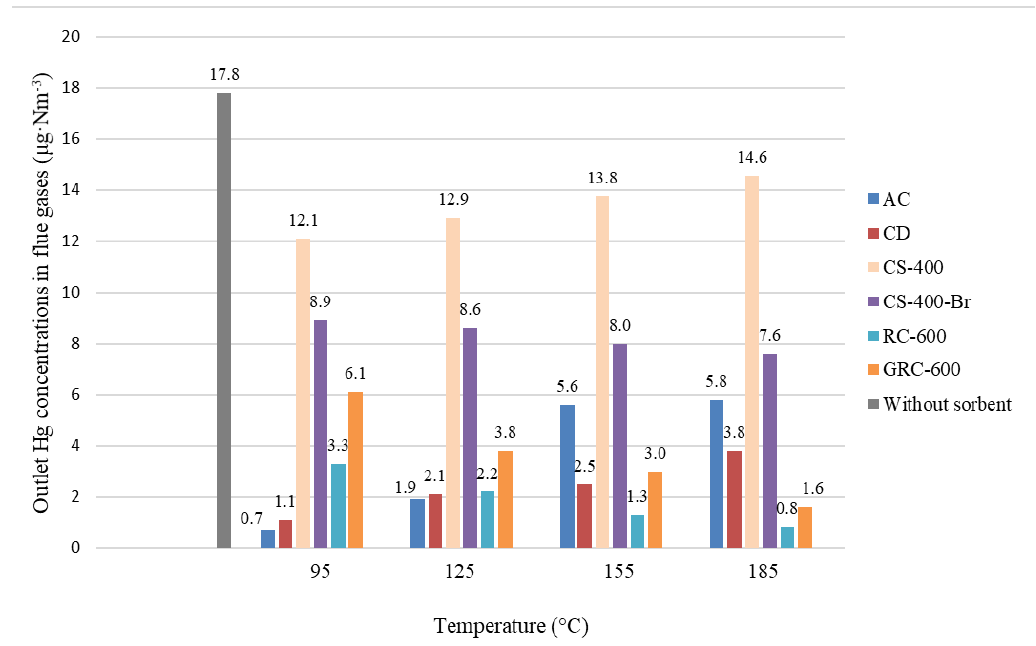
Figure 6. Concentration of mercury in raw flue gas and flue gases cleaned by LCOA depending on the temperature .